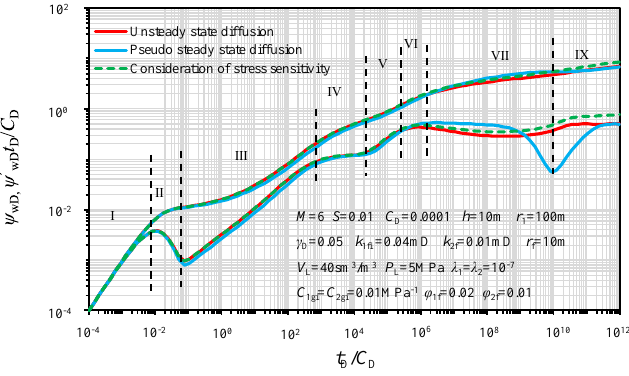
Figure 6. Type curves for the proposed model.